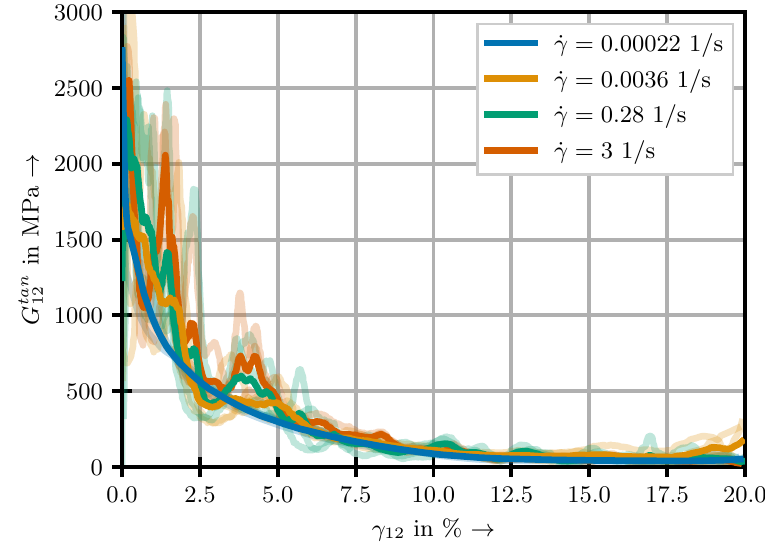
Figure 7. Experimental tangent modulus for the